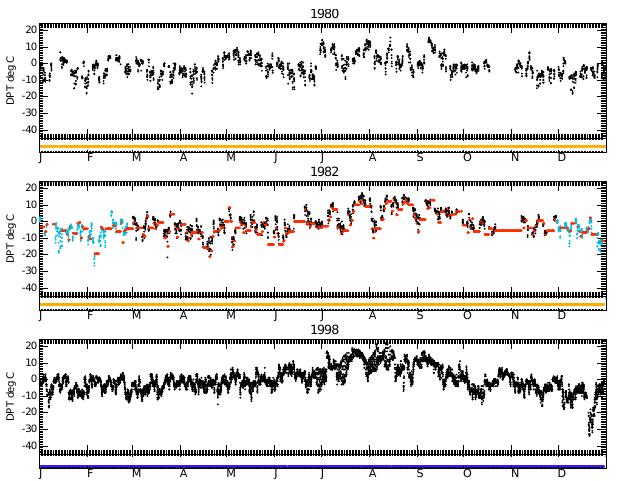
Fig. 11. Spike check (test 10) schematic, showing the requirements on the first differences inside and outside of a multi-point spike. The inset shows the spike of three observations clearly above the rest of the time series. The first difference value leading into the spike has to be greater than the threshold value, t , and the first difference value coming out of the spike has to be of the opposite direction and at least half the threshold value ( t/ 2). The differences outside and inside the spike (as pointed to by the red arrows) have to be less than half the threshold